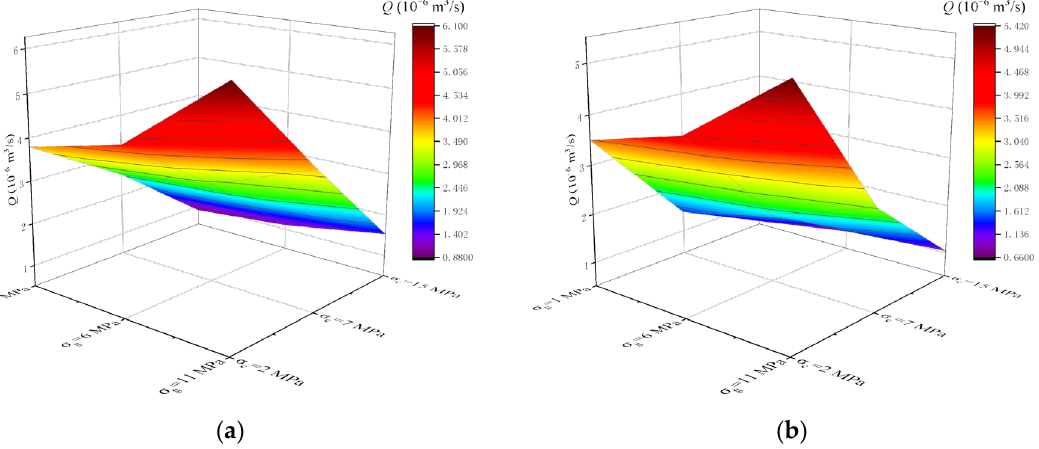
Figure 10. Example of seepage model ( JRC = 3).